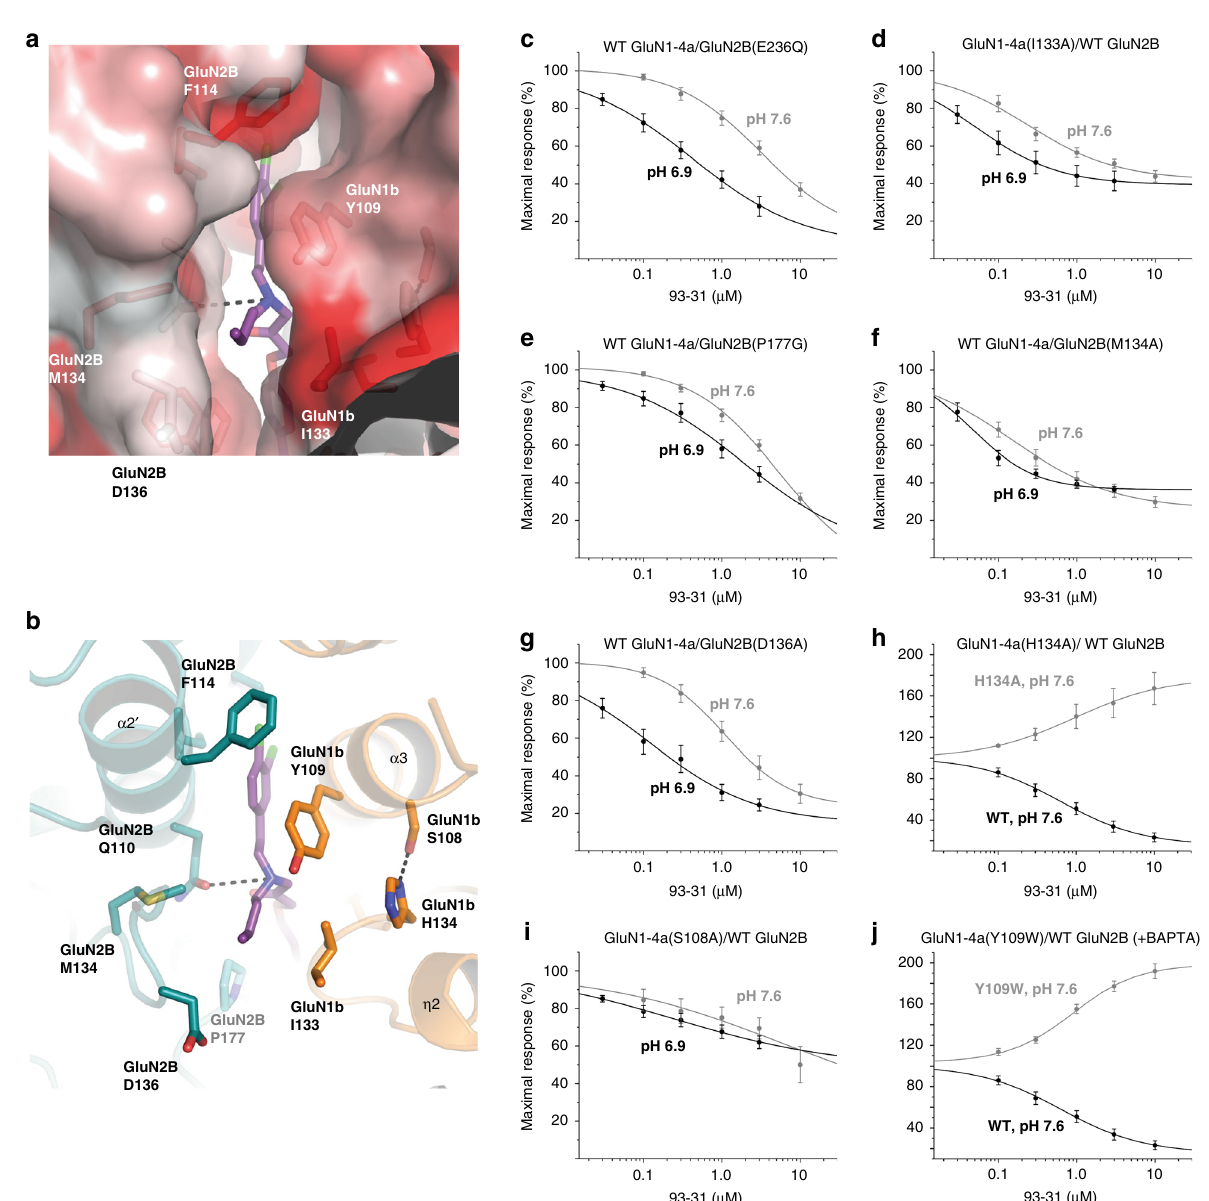
Fig. 4 TEVC concentration – response curves for GluN1-4a – GluN2B mutants. a The N-alkyl group of 93-31 is accommodated by the “ hydrophobic cage ” as shown by the hydrophobic (red) to non-hydrophobic (white) surface presentation. b Key residues at the GluN1/GluN2B ATD dimer interface that interact with the N-alkyl chain of 93-31 were mutated and evaluated for effects on pH sensitivity of 93-31. c – i Current responses to maximally effective concentration of glutamate and glycine (100 μ M glutamate, 30 μ M glycine) are shown in the presence of varying concentrations of 93-31 as a proportion of maximal response. Experiments conducted at pH 7.6 are shown in gray; experiments at pH 6.9 are shown in black. h , j Two mutations, GluN1-4a (His134Ala) and GluN1-4a(Tyr109Trp), convert 93-31 into a potentiator. Experiments here were performed at pH 7.6 (gray), with the wild-type curve displayed for comparison (black). Error bars represent mean ± S.E.M. See Tables 2 and 3 for fi tted IC 50 values and the number of independent